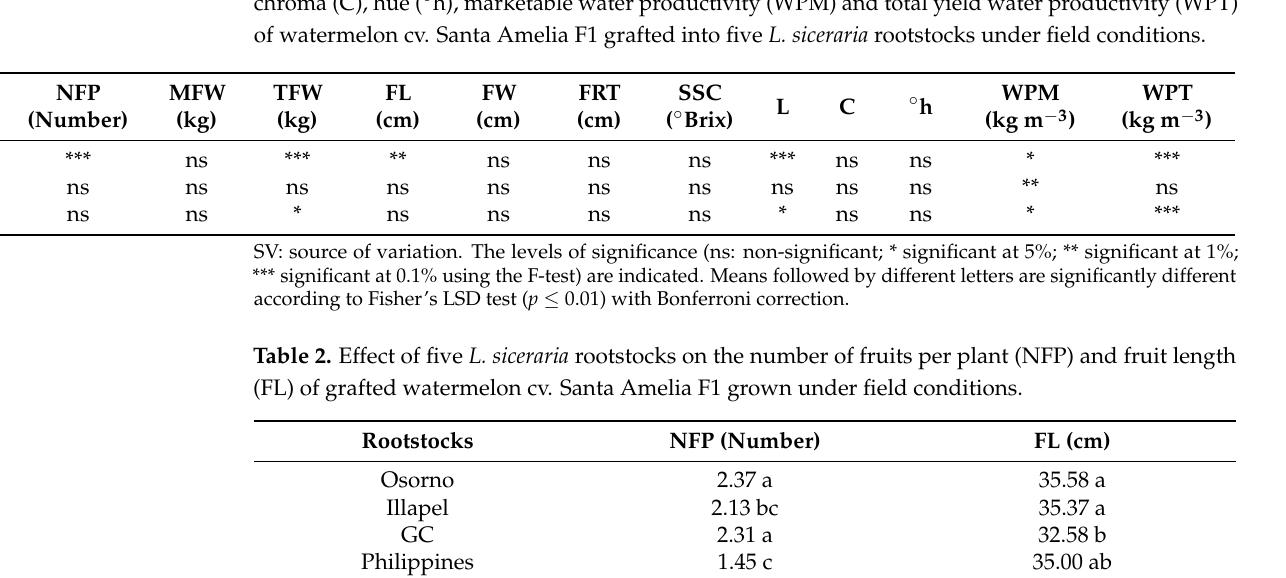
Table 1. Type III analysis of rootstocks (R), irrigation levels (I), and their interaction (R*I) on the